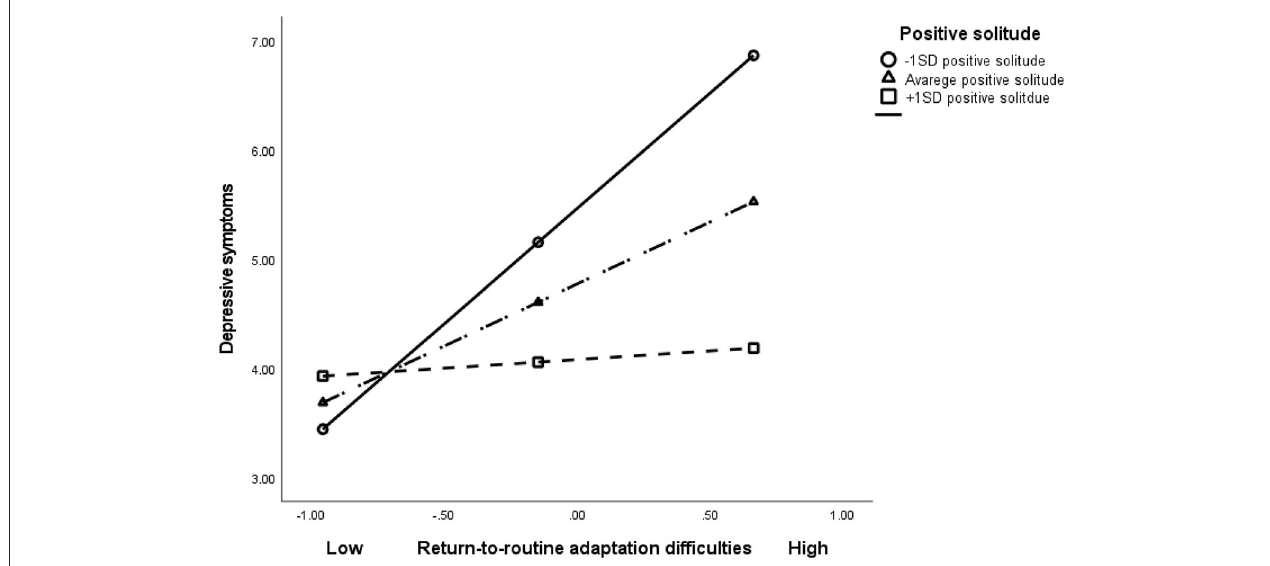
FIGURE 1 | The association between return-to-routine adaptation difficulties, positive solitude and depressive symptoms.